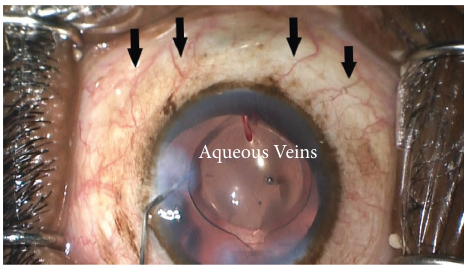
Figure 1: Hydrus stent inserted into Schlemm’s